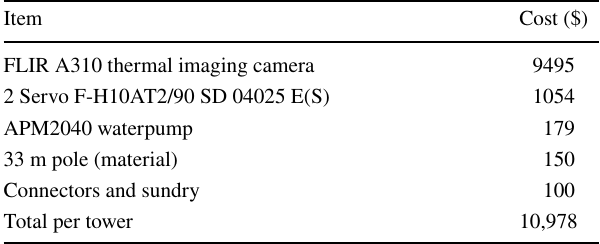
Table 2 Cost of individual tower